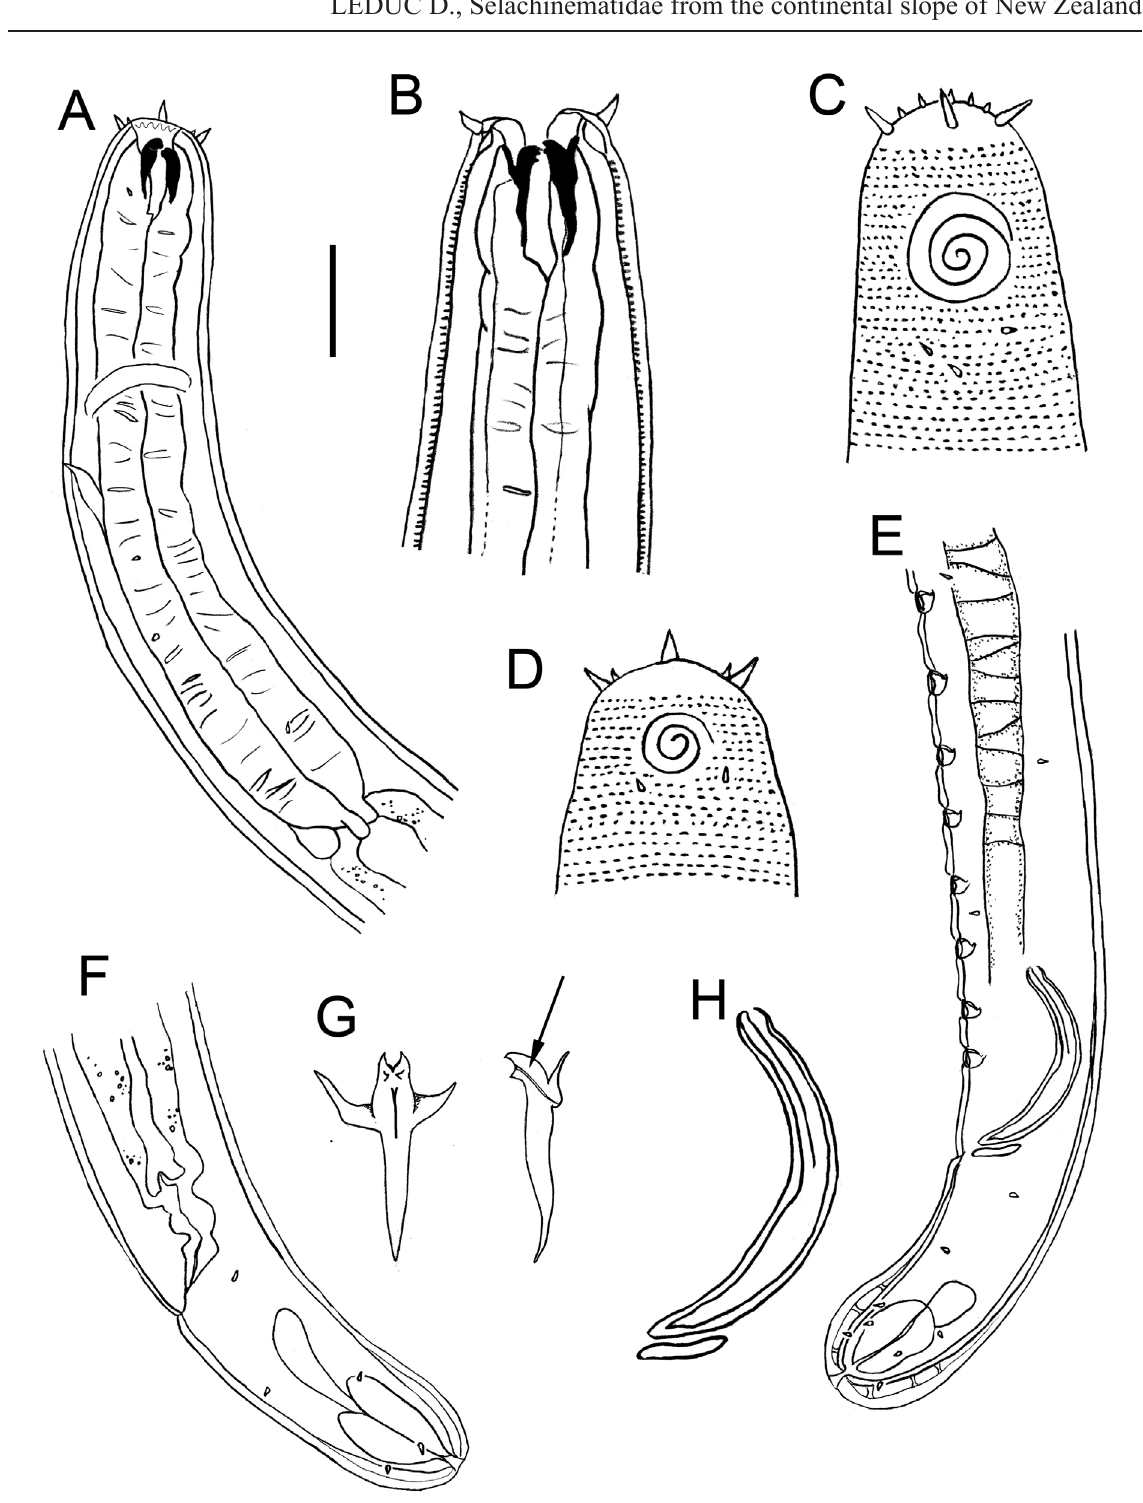
Fig. 1. Synonchiella rotundicauda sp. nov. A . Anterior body region of female. B . Male head. C . Surface view of male head. D . Surface view of female head. E . Male posterior body region. F . Female posterior body region. G . Mandibles, en face (left) and lateral (right) views. H . Spicule and gubernaculum. Arrow shows position of duct connecting anterior end of marginal tube and buccal cavity. Scale bar: A, E-F = 25 µ m; B-D = 15 µ m; G = 8 µ m; H =13